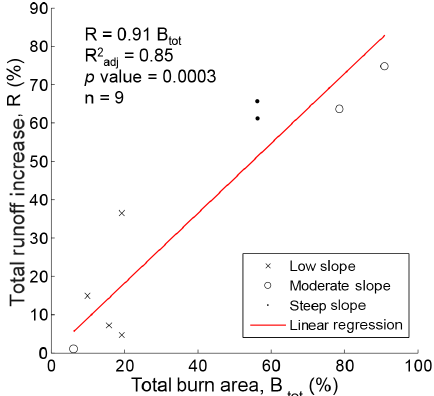
Figure 7. Linear regression model fitted between the total runoff volume increase and total burn area percentage. The catchment slope is categorized as low (slope < 0.30), moder- ate (0.30 ≤ slope < 0.40), and steep (slope ≥ 0.40) for each sub-